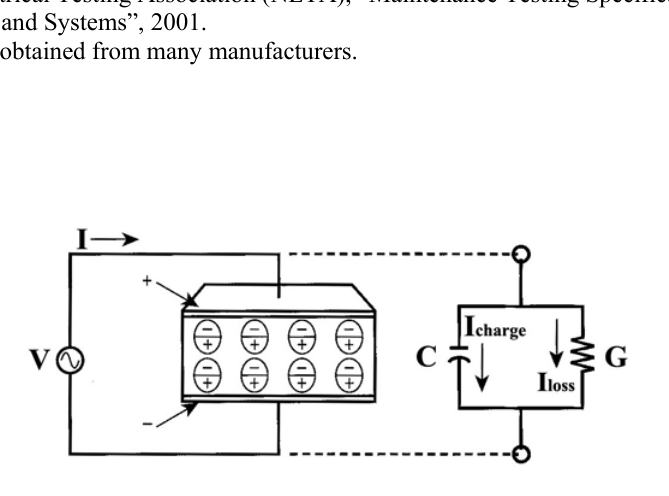
Figure 1. The equivalent circuit of the parallel plate capacitor incorporating the material under test (liquid or